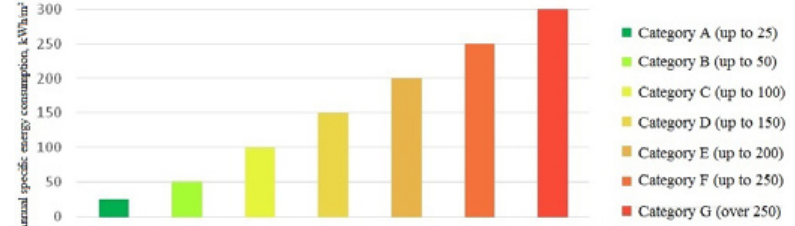
Fig. 3: Energy efficiency levels of buildings according tothe estimated annual specific energy consumption